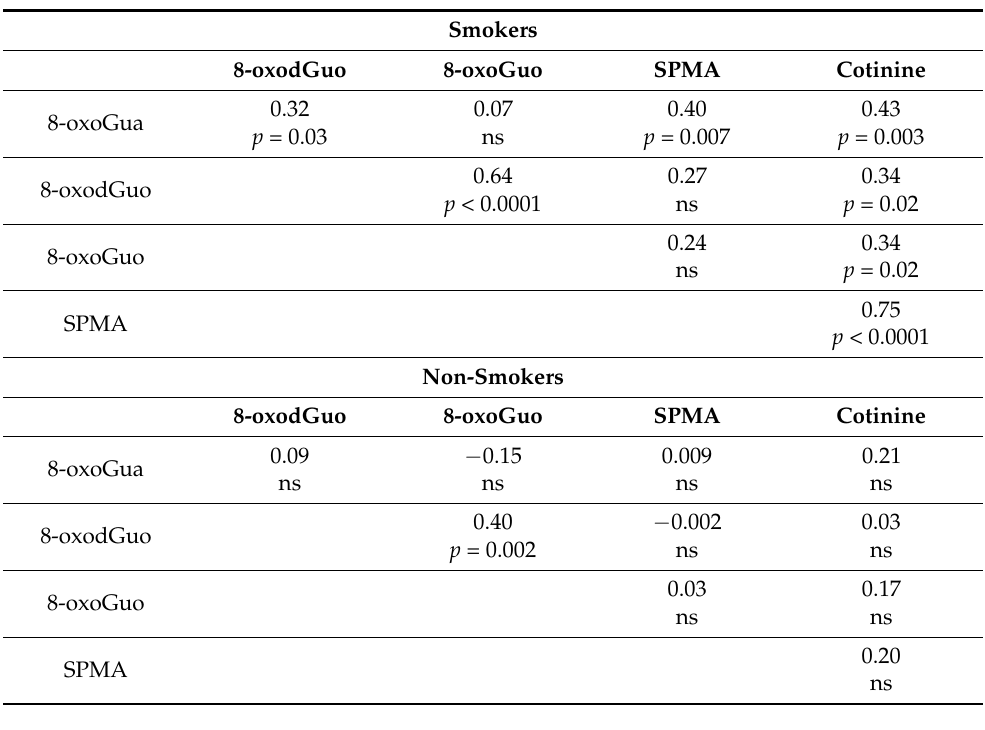
Table 6. Pearson’s log-correlations in Group